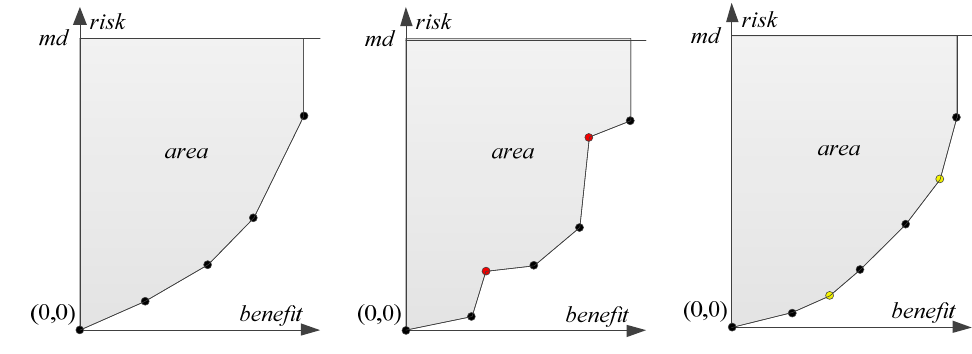
Figure 3. Diagram of the causes of area mutation.